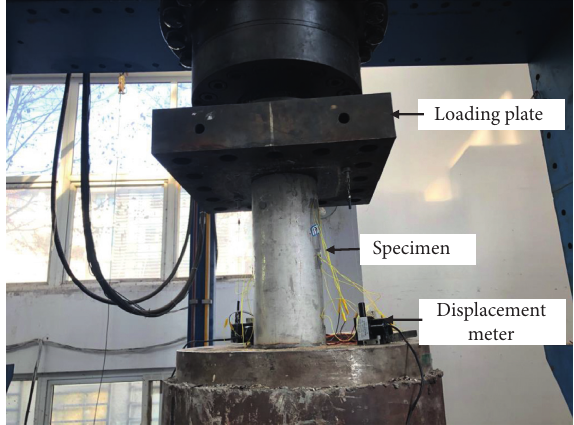
Figure 2: Loading